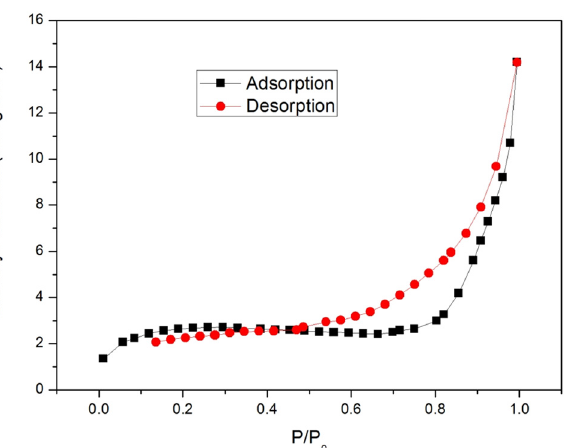
Figure 7: The removal of Zn - MOFs: ( a ) CR and ( b ) tetracycline hydrochloride.